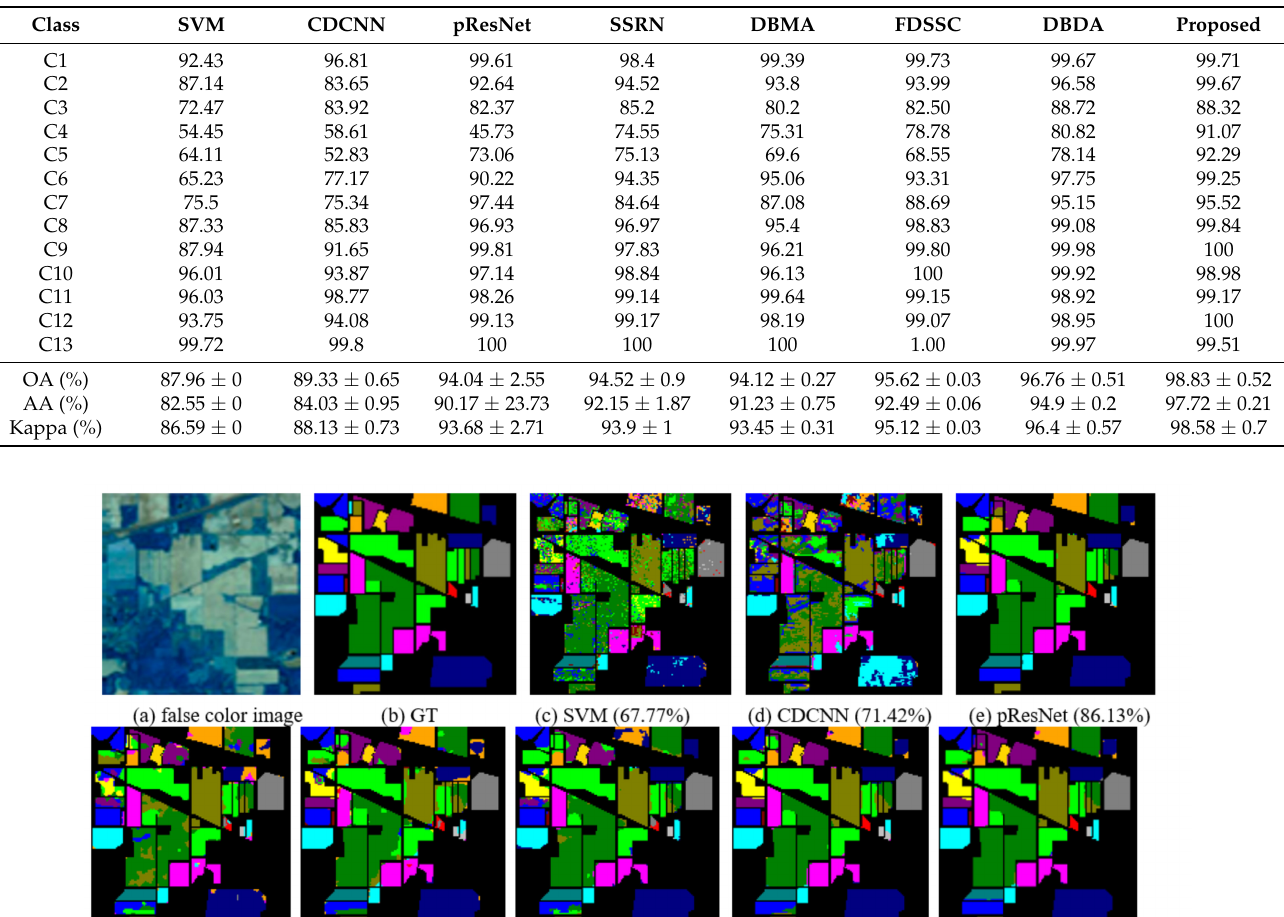
Table 9. KPI (OA, AA, Kappa) on Kennedy Space Center (KSC) data set with 5% training samples.